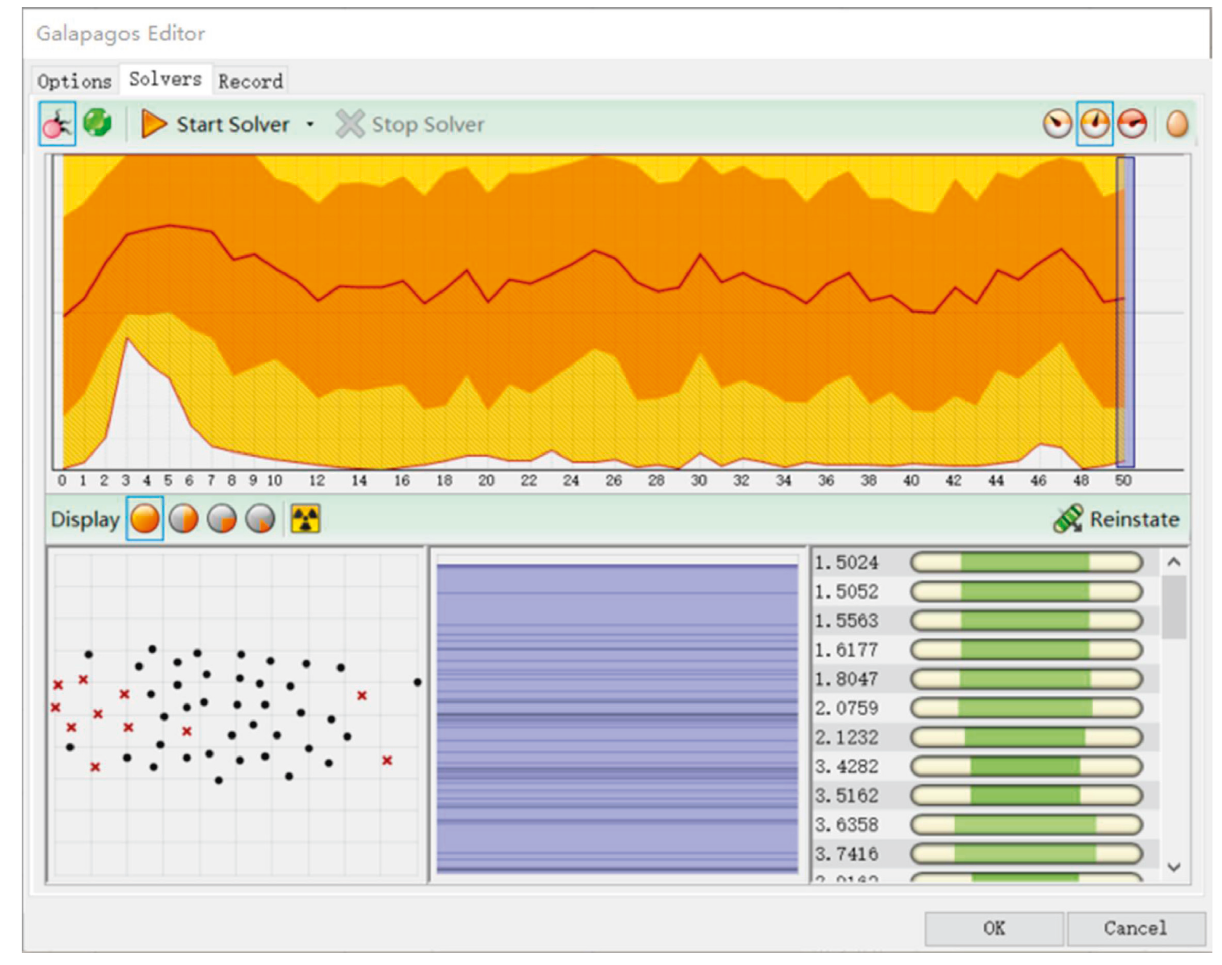
Figure 12: “Galapagos” operation interface. Table 3: Training sample output factor data